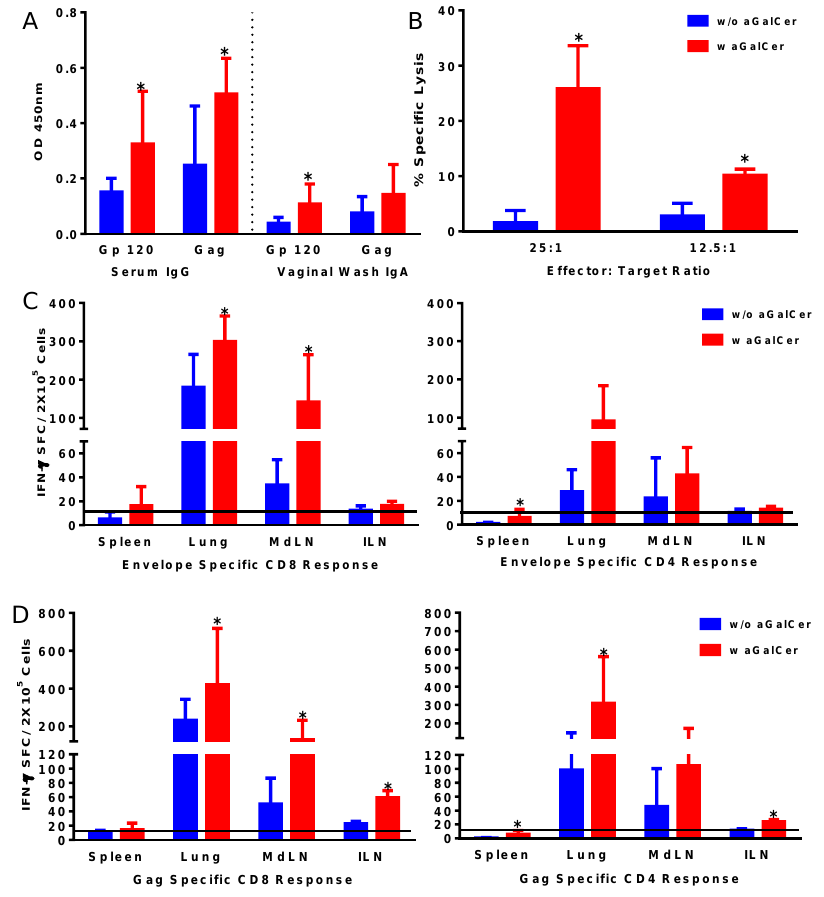
Figure 2. Induction of antigen-specific immune responses by intranasal immunization with adenoviral vectors expressing HIV-env and Gag using α-GalCer adjuvant. Mice were immunized by intranasal route with first generation adenoviral vectors with deletion of E1 gene (FG-Ad) HIV-env and FG-Ad HIV-Gag either alone or admixed with α-GalCer and were sacrificed 14 days later to determine systemic and mucosal adaptive immune responses. Antigen specific IgG and IgA antibody responses to recombinant HIV envelope protein gp120 and HIV Gag (p55) were determined in serum and vaginal washes by enzyme-linked immunosorbent assay (ELISA) ( A ). Antigen-specific cytolytic activity of splenocytes isolated from immunized mice were determined by the standard chromium-release assay employing the syngeneic P815 target cells pulsed with the HIV-gp120 peptide, at different effector to target cell ratios ( B ). Data were adjusted for background by subtracting control values (target cells not pulsed with the peptide). Single cell suspensions from spleen, lungs, mediastinal lymph nodes (MdLN), and Iliac lymph nodes (ILN) were analyzed for interferon-gamma (IFN-γ) production in response to stimulation with CD8 T and CD4 T cell epitope peptides from HIV-env ( C ) and HIV-Gag ( D ) by using a standard IFN-γ ELISpot assay. Data are shown as IFN-γ spot forming cells (SFC) per 2 × 10 5 input cells and antigen specific responses were adjusted to background medium control. Data are representative of two separate experiments and expressed as mean ± S.D. Statistical analyses between responses to different immunizations were performed using Mann Whitney Test, * ( p ≤ 0.05) between immunizations with Ad vectors alone and Ad vectors admixed with α-GalCer.